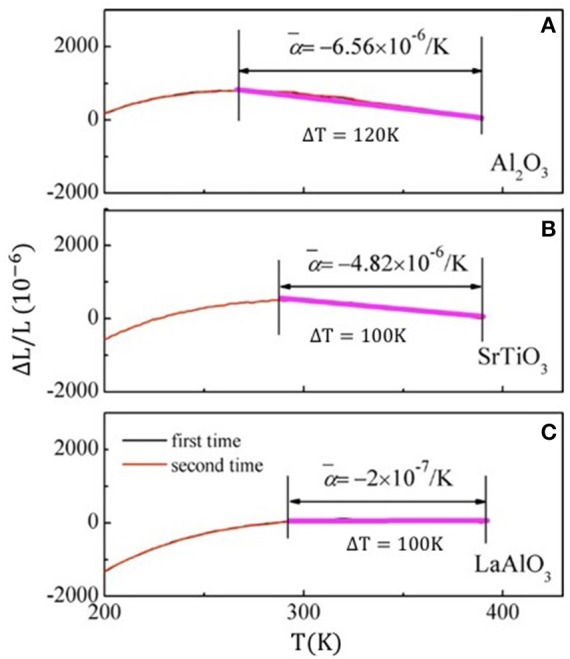
Temperature dependent linear thermal expansion ΔL/L for the Mn-Co-Ge-In thin films grown on Al2O3
(A), SrTiO3
(B), LaAlO3
(C). Each has been repeated at least two times. Reprinted with permission from Liu et al. (2018).